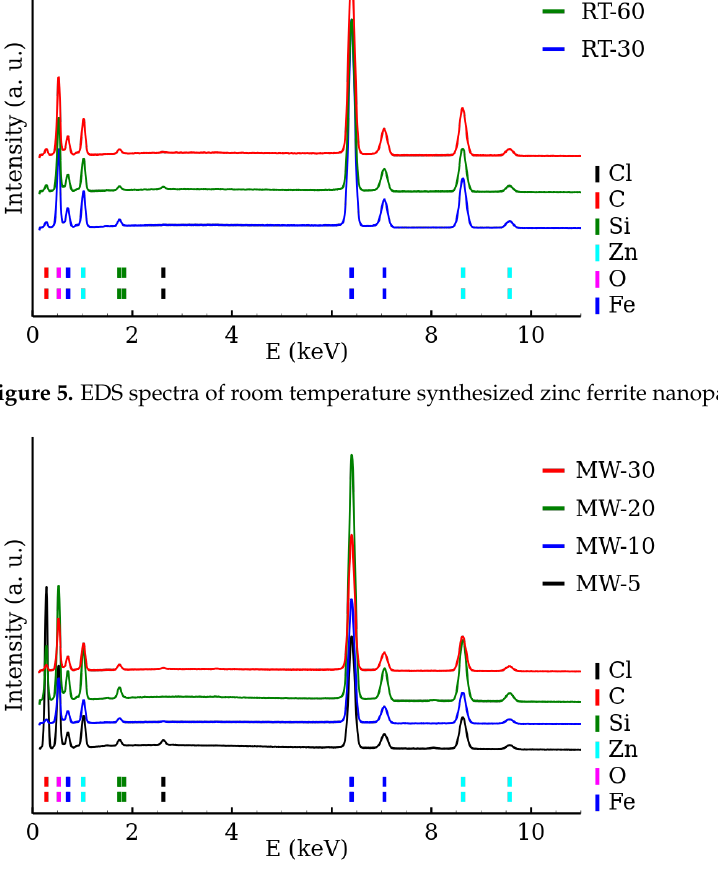
Figure 6. EDS spectra of zinc ferrite nanoparticles prepared by the microwave-enhanced synthesis. Table 3. Quantification of EDS spectra of zinc ferrite samples in atomic concentration, where balance is the sum of elements, which are at detection